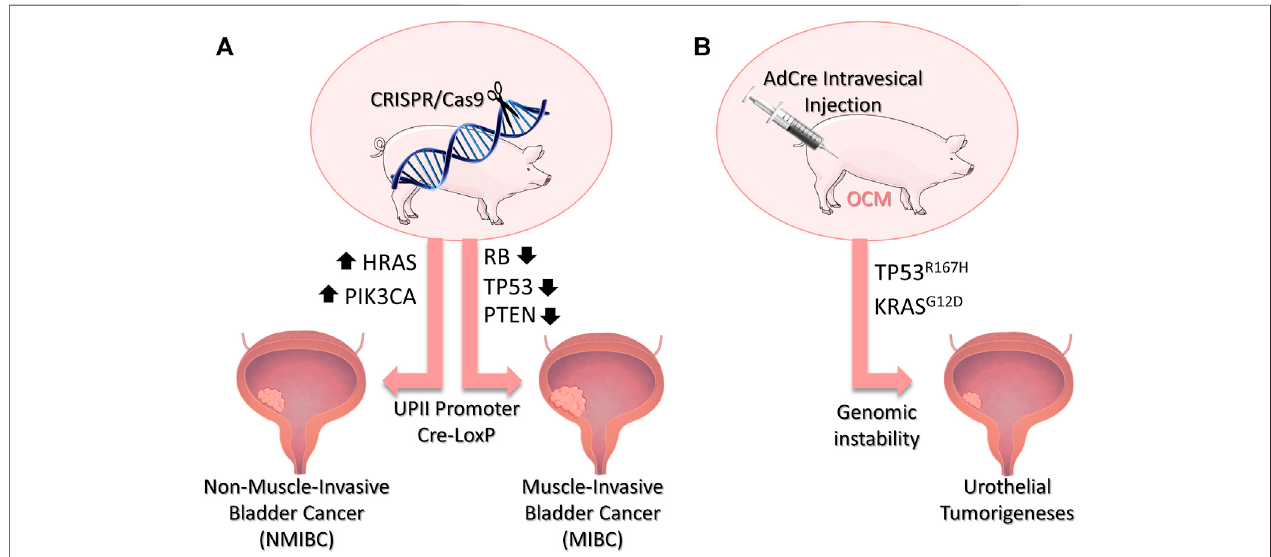
FIGURE 2 | PorcineBladderCancerModels. (A) Potentialgeneticmodi fi cationsinswinetodevelopbladdercancermodels throughCRISPR/Cas9technology.Mutations resulting in the activation of the PIK3CA and HRAS genes could be explored to develop MNIBC, while inactivation of the genes Rb, TP53 and/or PTEN are potentials targets to modelMIBC.TheadditionofUPIIpromoterandtheCre-LoxPsystemwouldallowforaurothelial-inducedexpressionofthetarget-genes. (B) TheOncopig Cancer Model(OCM) holdsinitsgenomemutatedTP53 R167H andKRAS G12D whichareactivateduponAdCreinjection.IntravesicalinjectionofAdCreintheOCMwouldresultintheexpressionof the transgenes and genomic instability, possibly leading to urothelial tumorigeneses. Bladder image obtained from Biorender (https://biorender.com/)